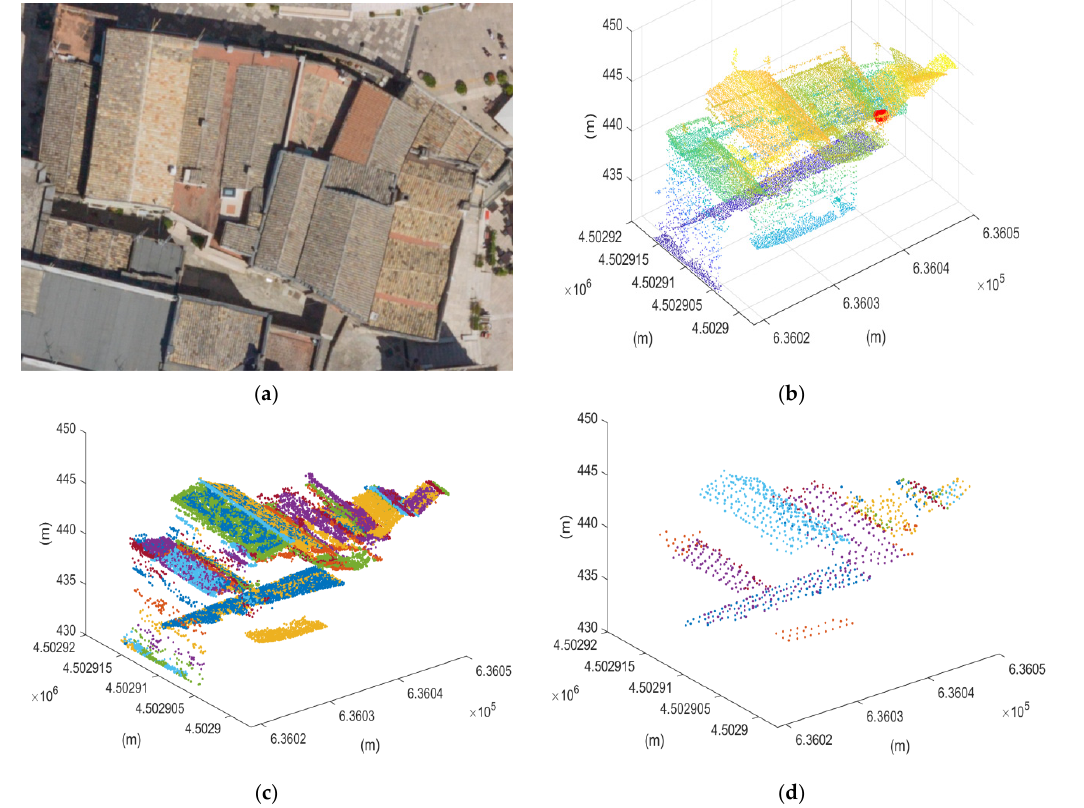
Figure 1. Clustering and segmentation of roof light detection and ranging (LIDAR) points. ( a ) orthopotho provided by GEOCART; ( b ) LIDAR points; ( c ) clustered points; ( d ) Planar segments.